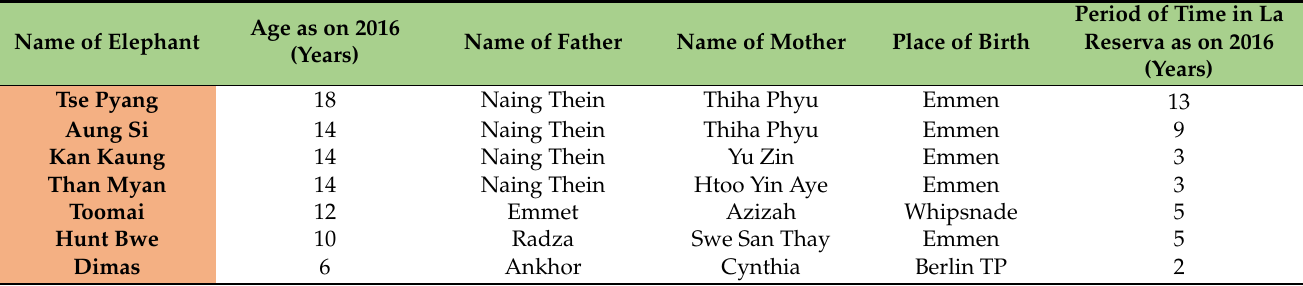
Table 1. Details of age, parents, place of birth, and time in the institution of the seven male captive Asian elephants ( Elephas maximus ) from La Reserva del Castillo de las